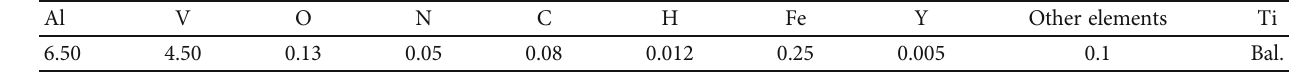
Table 1: Chemical composition of Ti64-LI powder in percentage by weight